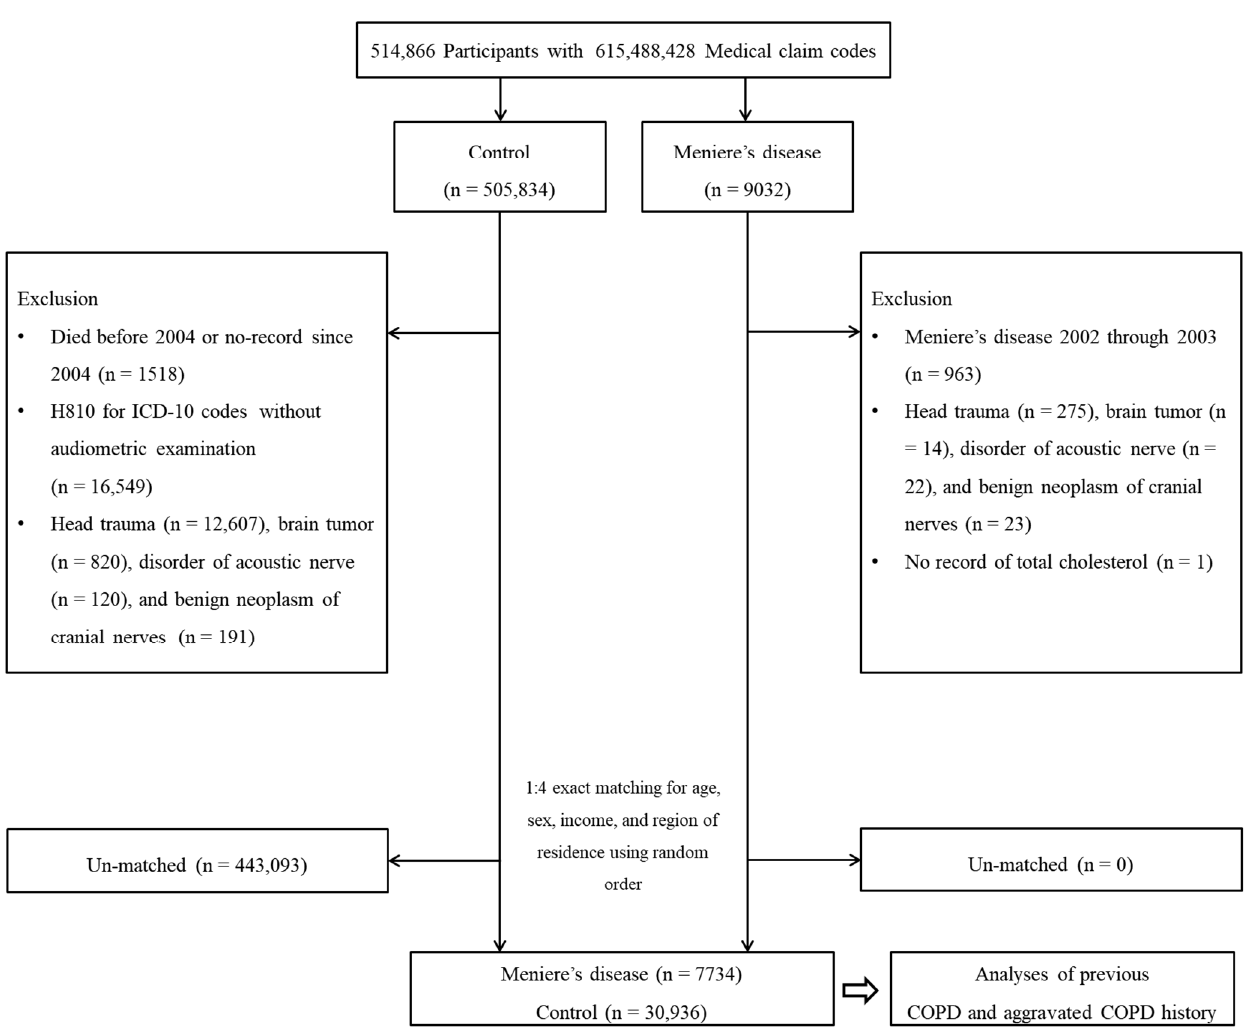
Figure 1. A schematic illustration of the participant selection process that was used in the present study. Of a total of 514,866 participants, 6054 Ménière’s disease participants were matched with 24,216 control participants for age, sex, income, and region of residence. Abbreviations: COPD, chronic obstructive pulmonary disease